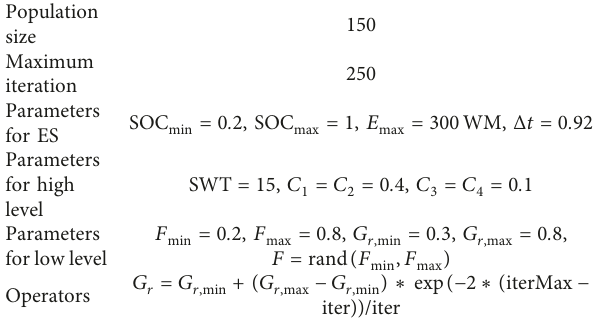
A LGORITHM 1: Elitist nondominated sorting strategy. Table 1: Related parameters for case